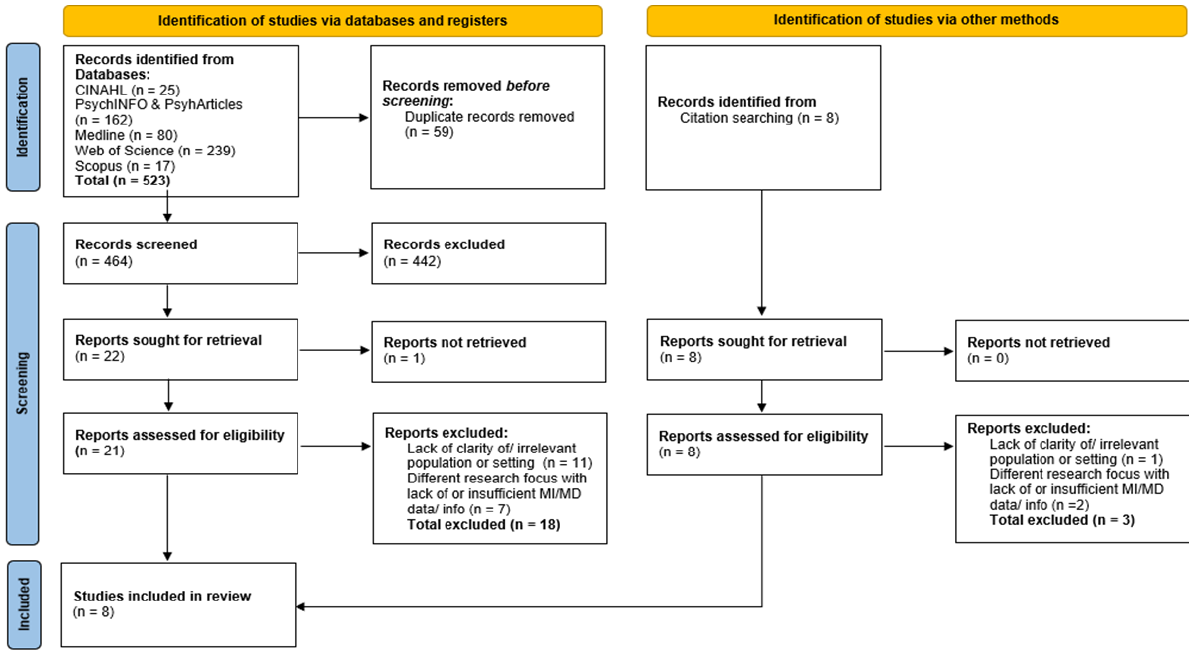
Figure 1. PRISMA flow diagram displaying studies that were identified, screened, and included in the review from databases, registers, and via other methods. Note: n = number of records